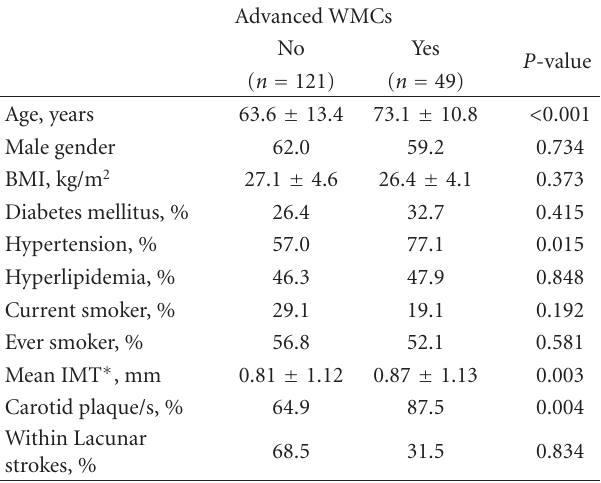
Table 3: Risk factors and carotid ultrasonography characteristics by severity of